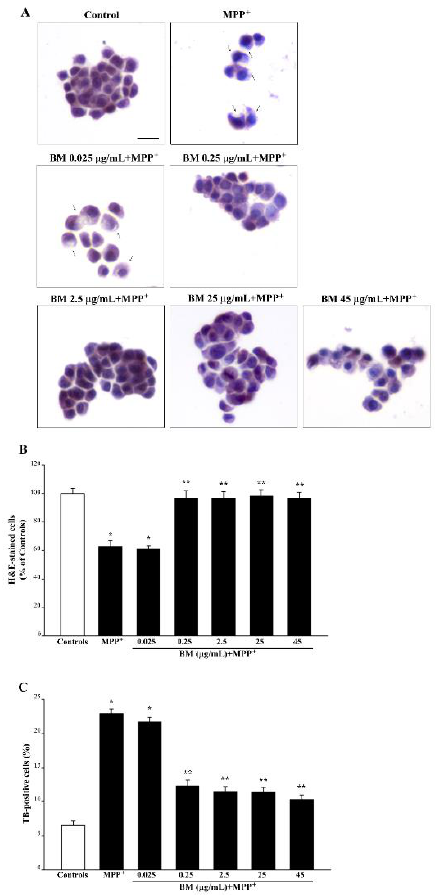
Figure 4. BM reduces toxicity induced by MPP + . ( A ) Representative H&E pictures show marked morphological changes induced by MPP + (100 µ M) compared with control. Note the intense hema- toxylin staining and altered shape (arrows) of PC12 cells treated with MPP + , which is prevented by pre-treating cells with various doses of BM. Assessment of PC12 cell viability through ( B ) H&E staining, and ( C ) TB staining following exposure to MPP + (100 μ M) alone or in combination with increasing BM doses (from 0.025 µ g/mL up to 45 µ g/mL). Values are given as the mean percentage ± S.E.M. of cells from three independent experiments. * p < 0.05 compared with controls; ** p < 0.05 compared with MPP + . Scale bar = 12 µ